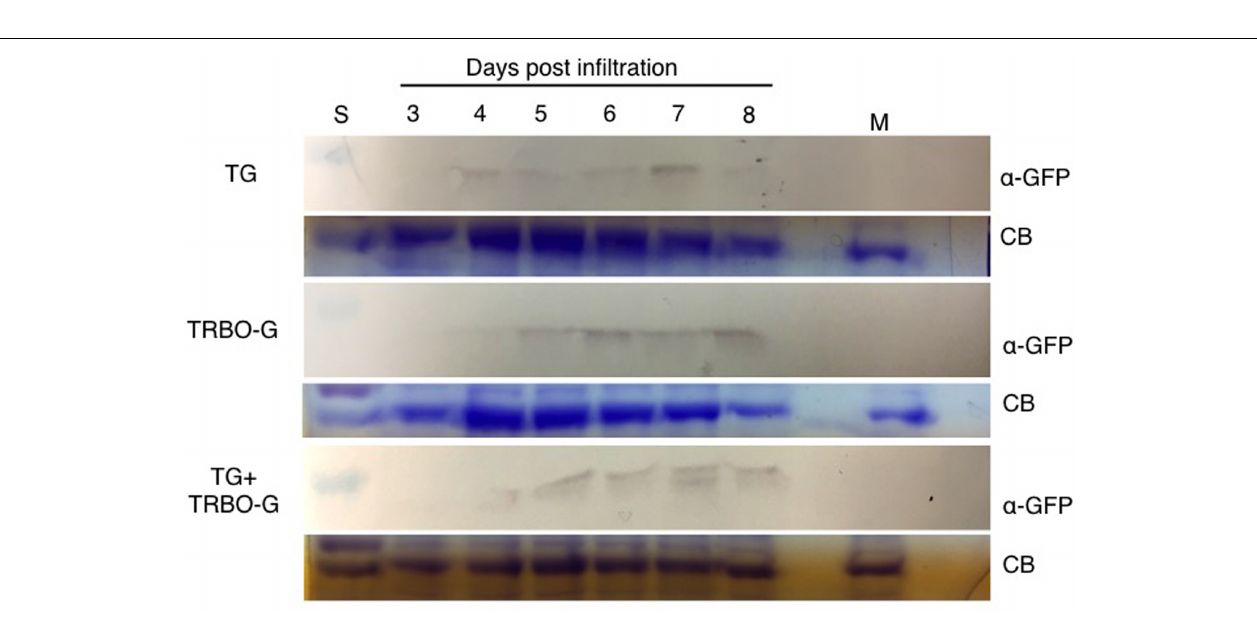
FIGURE 4 | GFP analysis in N. benthamiana based on green fluorescence and western blot assays. (A) GFP imaging at 3 dpi in N. benthamiana infiltrated with TG and TRBO-G, TG+TRBO-G. (B) GFP protein analysis in N. benthamiana infiltrated as for (A) . GFP expression for TG, TRBO-G, and TG+TRBO-G was monitored each day from 3 to 7 days post-infiltration (dpi) with Mock (M) and 00 (control Agrobacterium expressing an empty TRV vector) collected at 7 dpi. In each case the upper panels are western blots for GFP detection, while the lower panels show the corresponding Coomassie Brilliant Blue (CB) staining of the gels for loading comparison. The red colored size marker (S) on the left of western blots is 25 kDa, while the size of the intense CB band of a host protein is about 55 kDa as inferred from the size marker on the left.